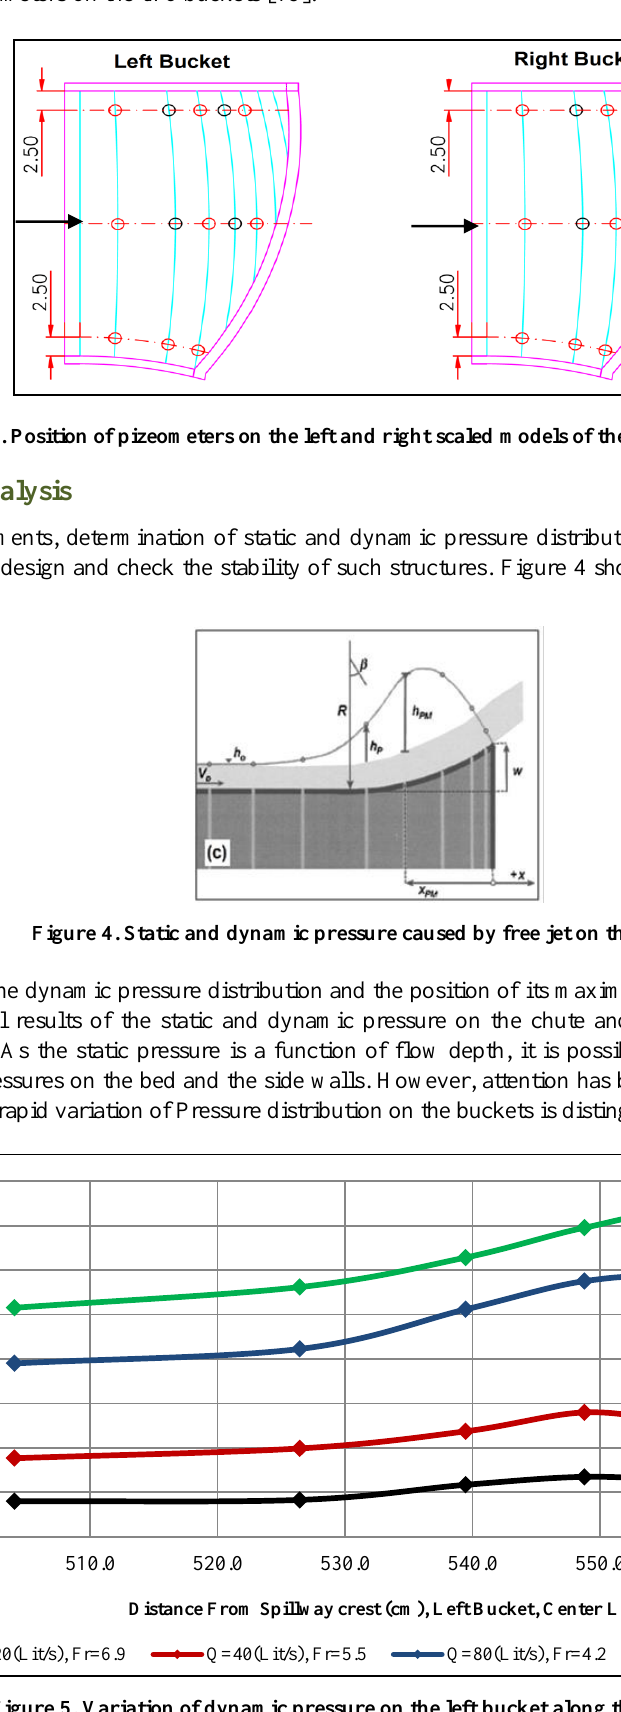
Figure 5. Variation of dynamic pressure on the left bucket along the